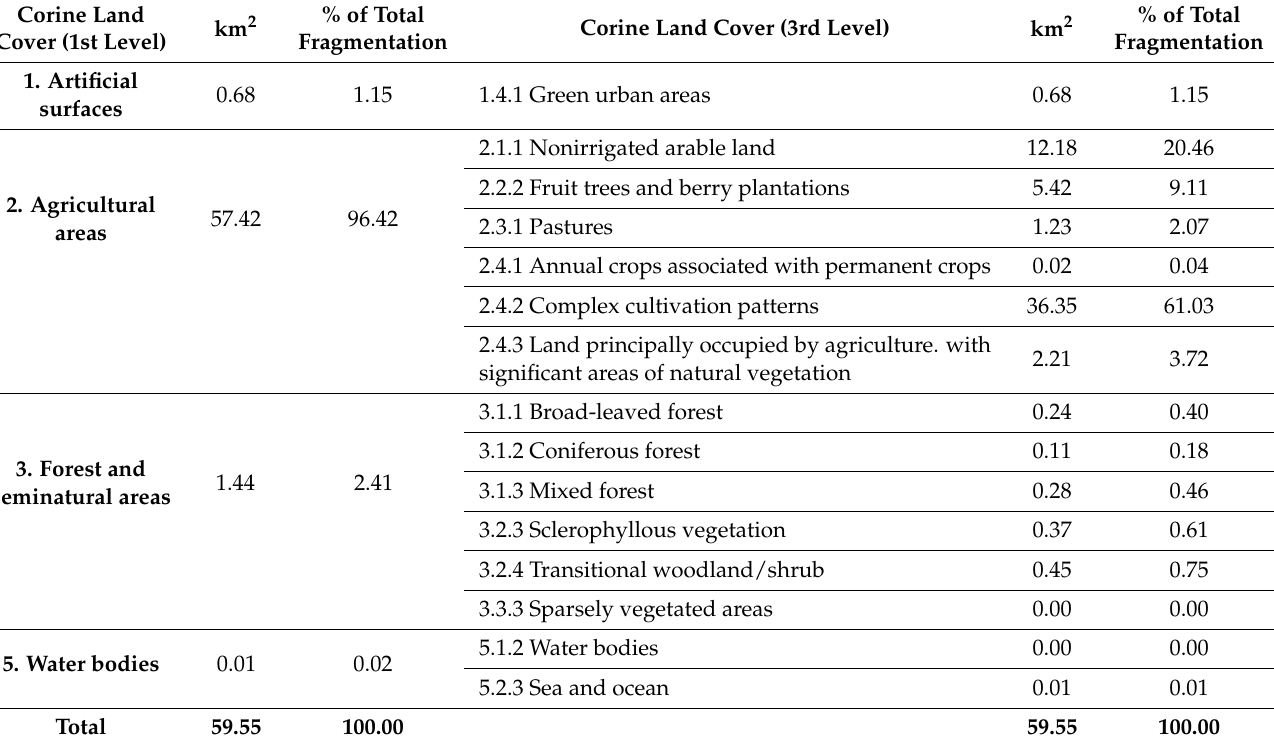
Table 2. Eroded area in km 2 and in percentage of total fragmentation for each category of land use, for both the first- and third-level Corine Land Cover